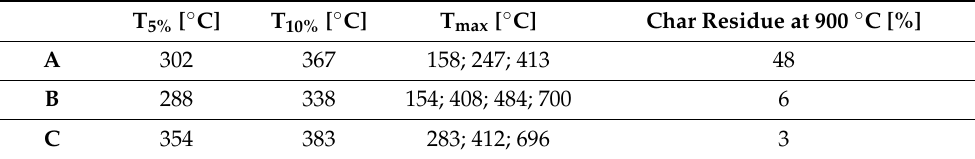
Table 3. Thermal properties of molecules A – C